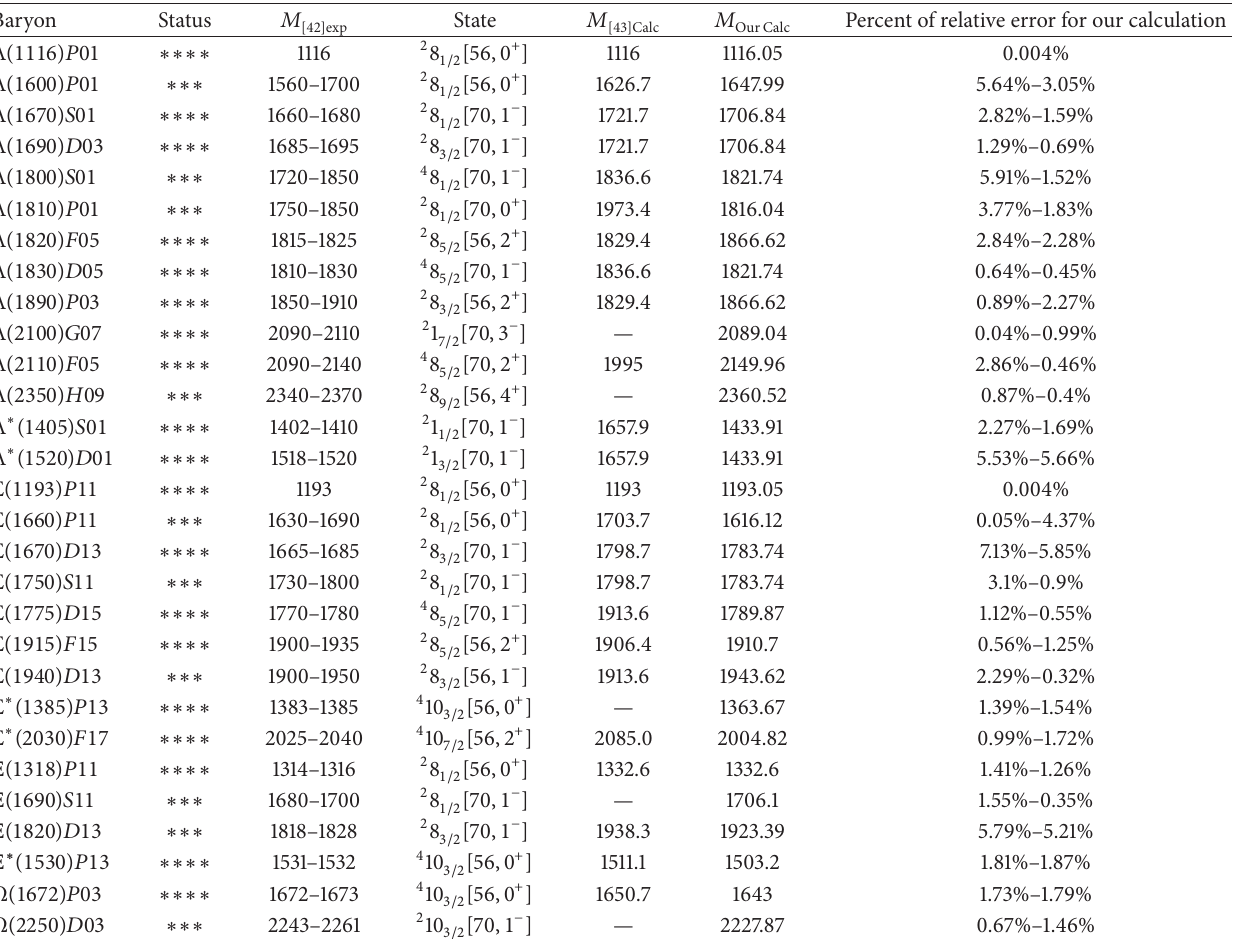
Table 4: Like Table 3, but for Λ , Σ , Ξ , and Ω